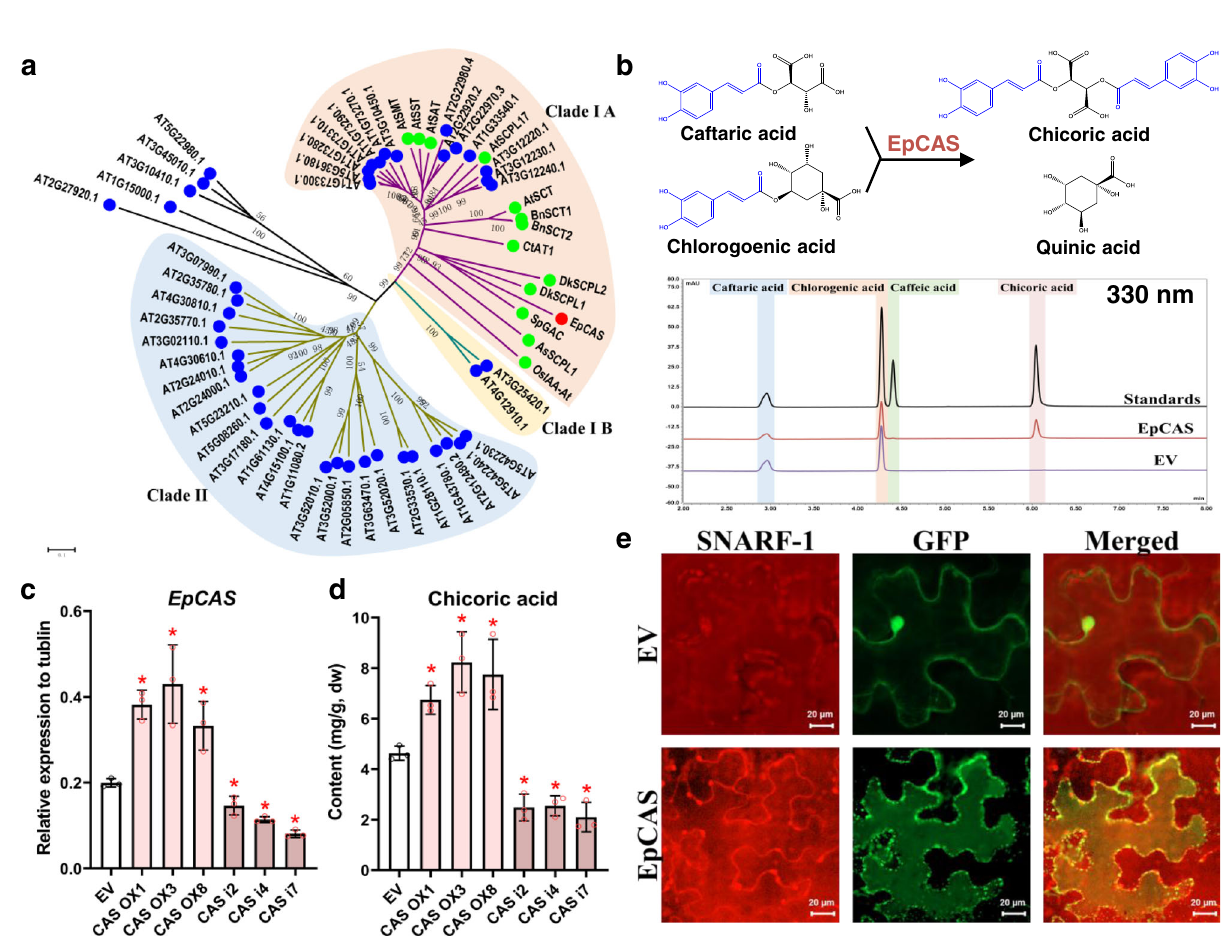
Fig. 3 A SCPL enzyme catalyzes the biosynthesis of chicoric acid. a Phylogenic analysis of EpCAS together with Arabidopsis thaliana and several additional functionally characterized SCPLs. EpCAS is marked in red. SCPLs previously characterized functionally are marked in green. b UPLC detection of chicoric acid generated by recombinant EpCAS. c Relative expression levels of EpCAS and d chicoric acid contents in transgenic over expression (OX) and RNAi (i) hairy root lines. Data are mean±s.d. ( n = 3 biologically independent samples). * indicates a signi fi cant difference from the empty vector (EV) control line ( P < 0.05) analyzed by two-sided Student ’ s t -test. * P = 0.0008 (CAS OX1), * P = 0.0123 (CAS OX3), * P = 0.0162 (CAS OX8), * P = 0.0187 (CAS i2), * P = 0.0002 (CAS i4), * P = 0.0001 (CAS i7) in c ; * P = 0.0045 (CAS OX1), * P = 0.0071 (CAS OX3), * P = 0.0189 (CAS OX8), * P = 0.0034 (CAS i2), * P = 0.0017 (CAS i4), * P = 0.0025 (CAS i7) in d . e EpCAS is vacuole-localized in Nicotiana benthamiana leaves. The vacuole was visualized by SNARF-1 55 . Scale bars, 20 µ m. This experiment was repeated independently three times with similar results. Source data underlying c and d are provided as a Source Data fi